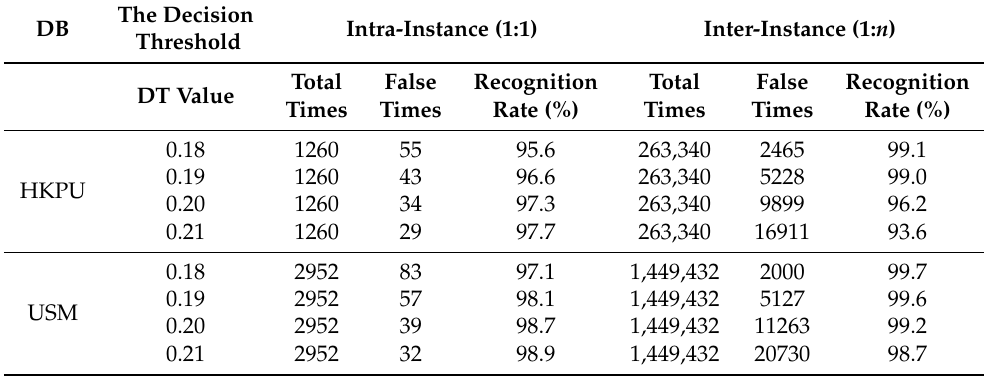
Table 3. The recognition rate under different DT